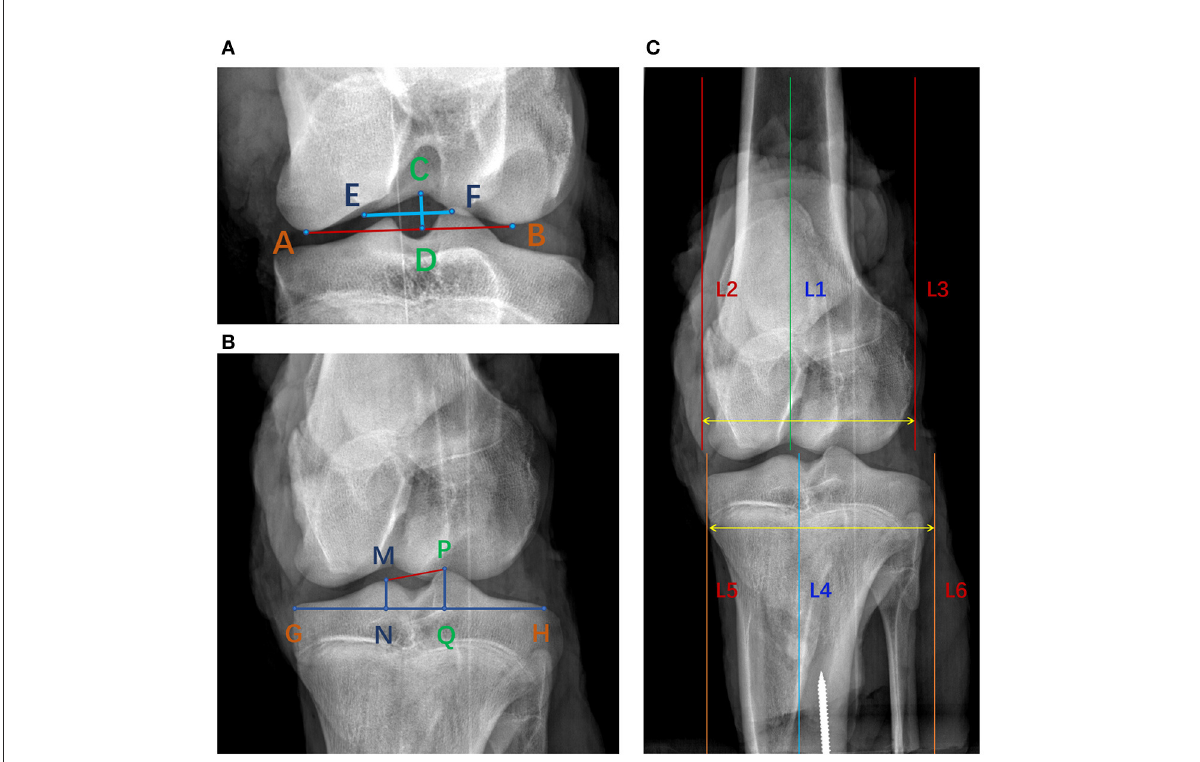
FIGURE1 Measurement of bony parameters on coronal radiographs of porcine knee. (A) Line CD was the notch height and line EF was the notch width. S1 was the area of the femoral notch. (B) Line NQ was the width of the tibial interspinal fossa. S2 was the area of the tibial interspinal fossa. (C) The distance between line 2 and line 3 was the width of the femoral condyle and the distance between line 5 and line 6 was the width of the tibial